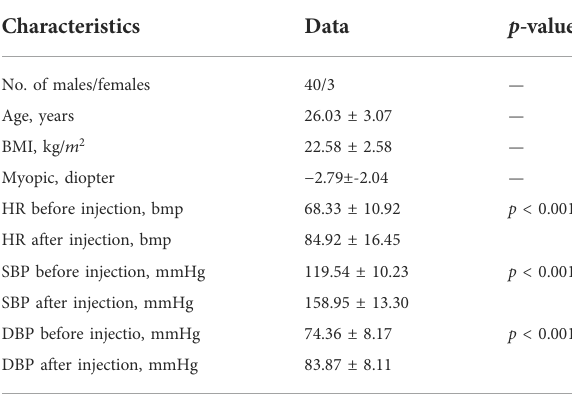
TABLE 1 Summary of participant characteristics.